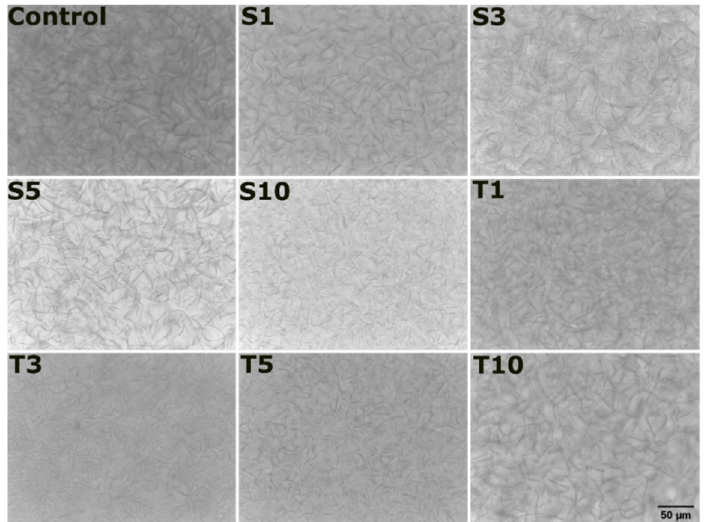
Figure 4. Bright-field micrographs of all the formulations. The details of abbreviations used are pro- vided in Section 4.2 (Table